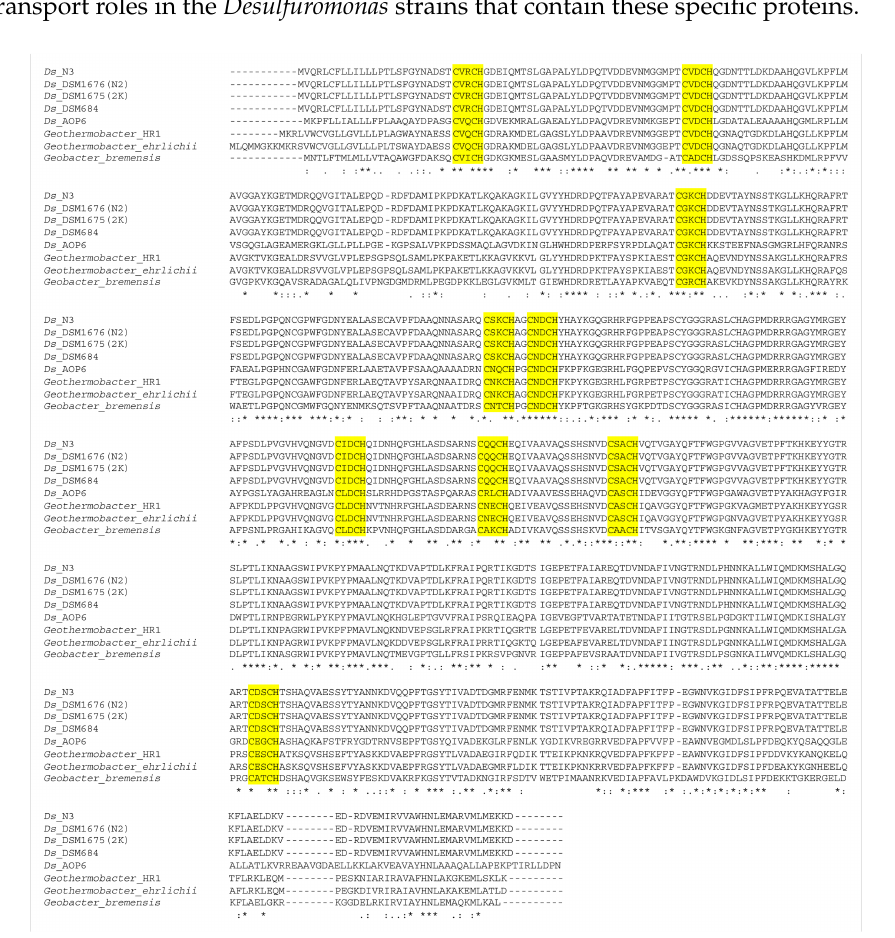
Figure 8. Alignment of the large unique multiheme cytochrome C sequences from Desulfuromonas genomes and their closest relatives from Geothermobacter and Geobacter species. Potential heme-binding sites are marked in yellow. Ds = Desulfuromonas acetoxidans